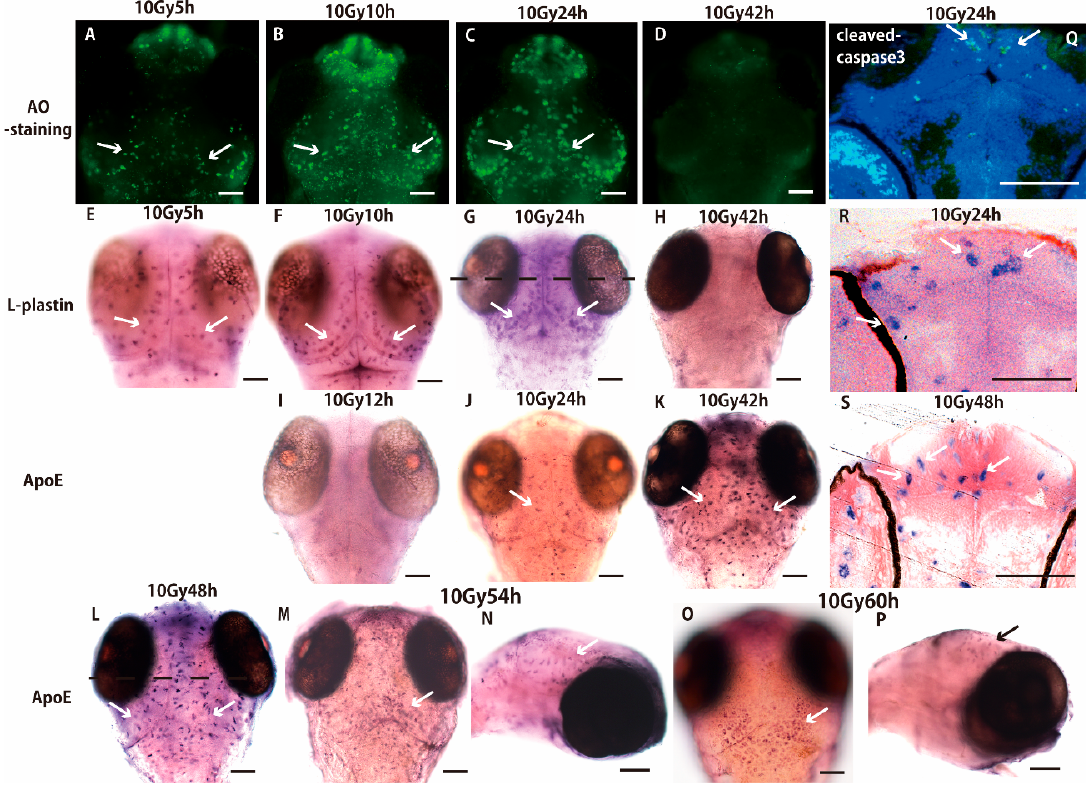
Figure 1. Sequential process of microglial activation following γ -ray irradiation. Acridine orange (AO)-positive apoptotic neurons started to form rosette-shaped clusters 5 h after the irradiation of γ ray (10 Gy) ( A ). Number of clusters increased and they were located in the marginal area of the optic tectum (OT) 10–24 h after the irradiation ( B , C ) then disappeared 42 h after the irradiation ( D ). The distribution of L -plastin mRNA revealed by Whole-Mount In Situ Hybridization (WISH) was identical to that of AO-positive apoptotic neurons during 5–42 h after the irradiation ( E – H ). In a histological section of the WISH-processed brain 24 h after the irradiation ( G ) prepared at the dotted line, L -plastin expressing microglia were distributed in the marginal area of the irradiated OT (arrows in R ) in the same manner as that of cleaved-caspase 3 positive apoptotic neurons (arrows in Q ). By contrast, no ApolipoproteinE (ApoE)-expressing microglia were present 12 h after the irradiation ( I ). ApoE-expressing microglia started to appear 24 h after the irradiation (arrow in J ) and they increased throughout the whole brain 42–48 h after the irradiation (arrows in K , L ). A histological section of the WISH-processed brain 48 h after irradiation ( L ) prepared at the dotted line in L shows that the activated microglia changed their cell appearance from ramified to amoeboid morphology (arrows in S ). Number of ApoE-expressing microglia decreased 54 h after the irradiation (arrows in M , N ) and completely disappeared within the brain, but accumulated on the dorsal surface of the brain 60 h after the irradiation (arrow in O , P ). AO-stained and WISH-processed brains in A – M and O show dorsal views, and ( N , P ) show lateral views. Scale bars = 100 μ m.